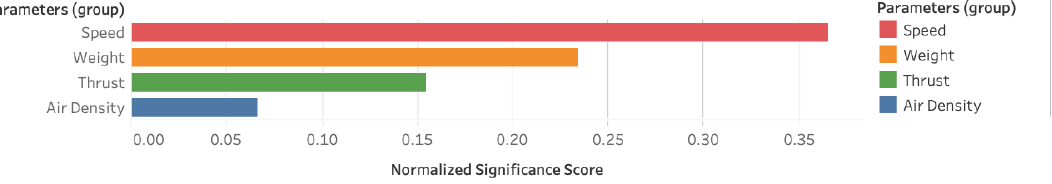
Figure 11. Criticalparameter groups obtained from SAFE framework for Tire Speed Event .